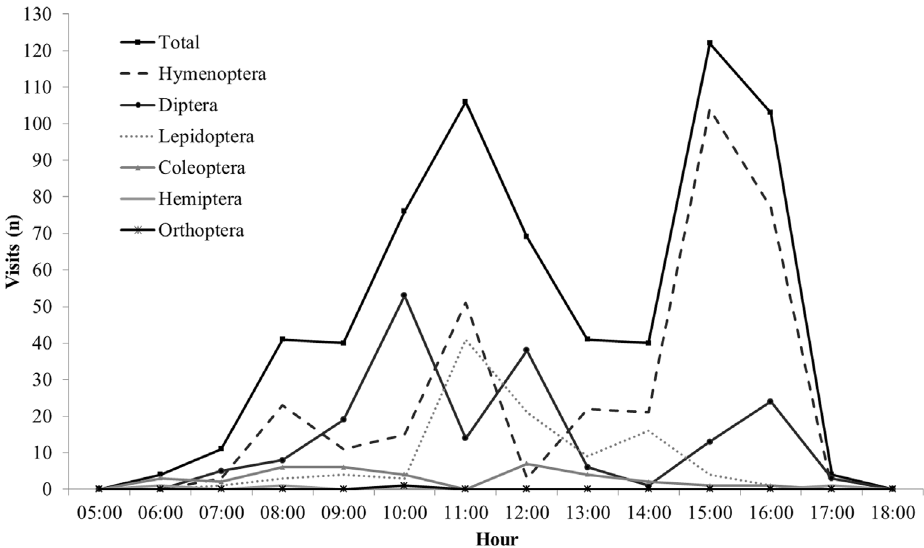
Figure 5 - Daily activity of Varronia curassavica Jacq. floral visitors between October of 2014 and March of 2015 in a sandbank environment, Joaquina, Florianópolis, Santa Catarina,